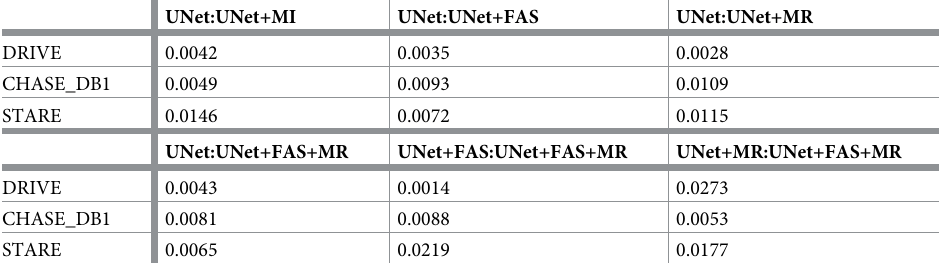
Table 2. P-value analysis results among various ablation models on different dataset. UNet:UNet+MI UNet:UNet+FAS UNet:UNet+MR DRIVE 0.0042 0.0035 0.0028 CHASE_DB1 0.0146 UNet:UNet+FAS+MR UNet+FAS:UNet+FAS+MR